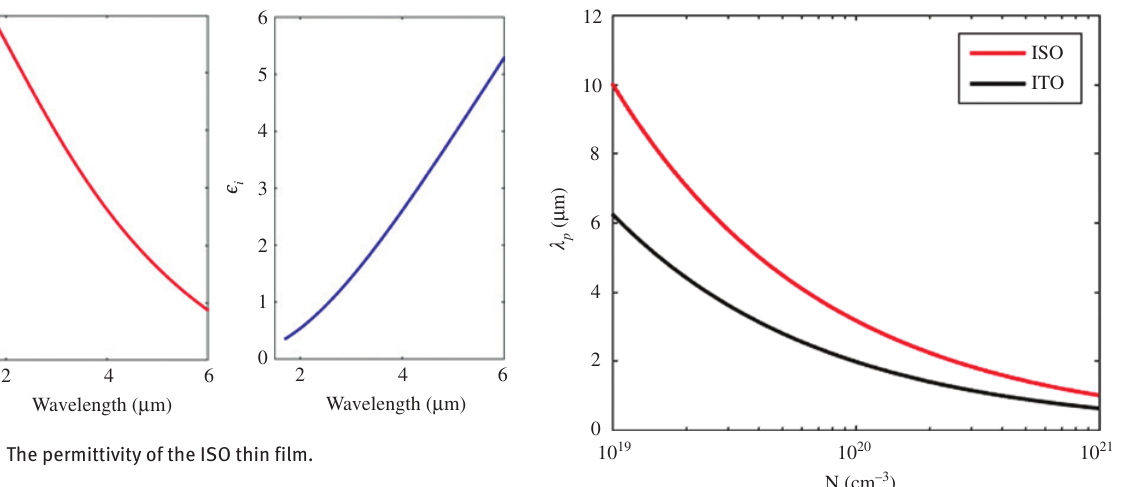
and m * = 0.90 m , e e